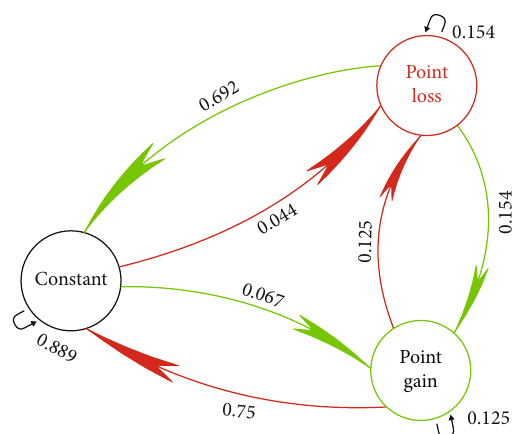
Figure 10: SIC Insurance Company equity transition matrix and diagram.